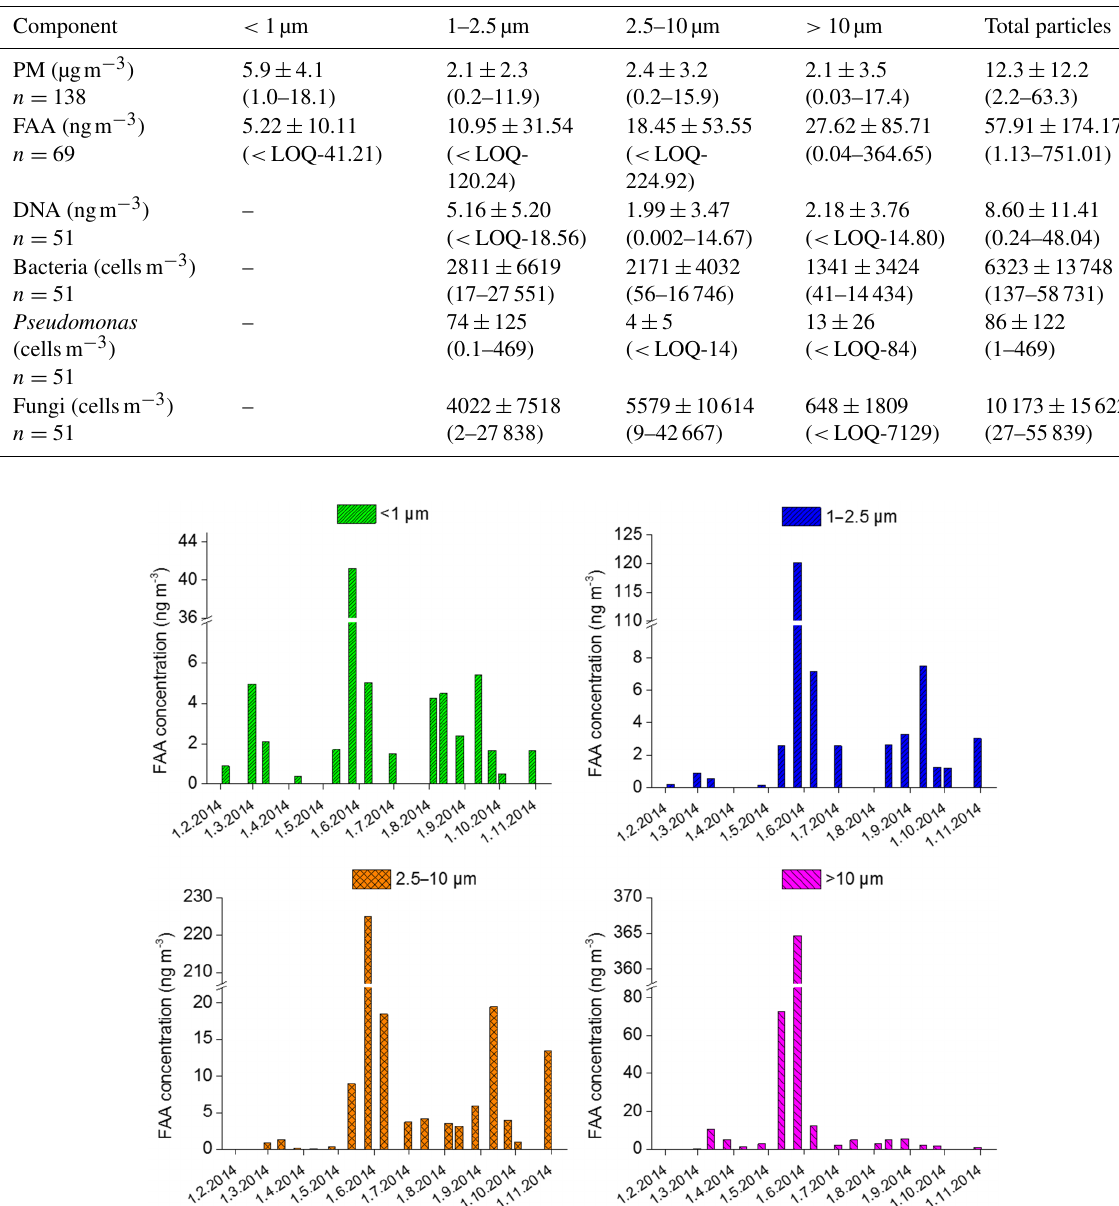
Figure 1. Free amino acid concentrations over the sampling period in different particle size fractions (date format is dd.mm.yyyy.). Note the different y axis scales in